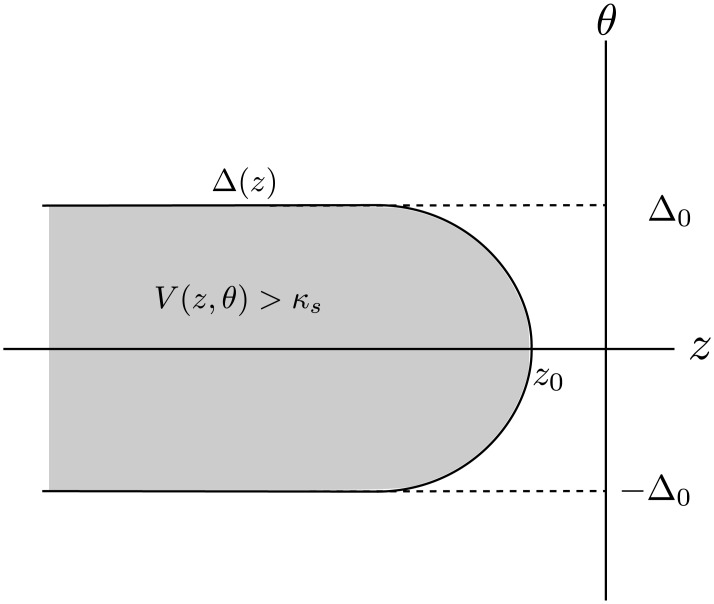
Schematic illustration of superficial layer traveling front solution V(z, θ) in the z-θ plane.The curve determined by ±Δ(z) separates the plane into a region of super threshold activity (grey) and sub threshold activity.